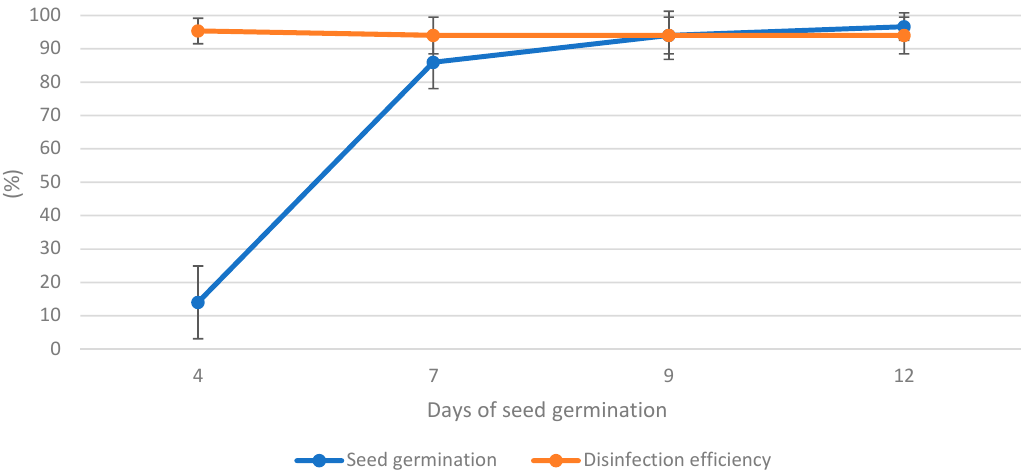
Figure 5. Scots pine seed germination and seed surface disinfection after 3 s of non-thermal plasma treatment. Observations after the 4th, 7th, 9th, and 12th days of seed germination. More details are given in the Methods.